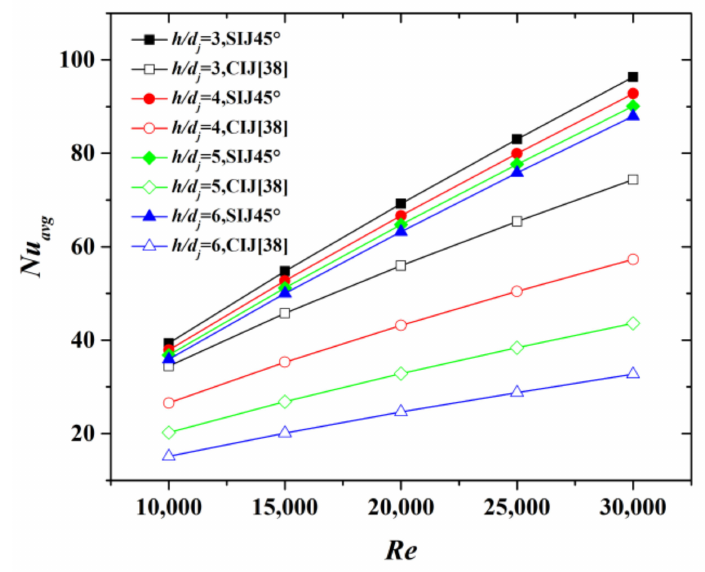
Figure 18. Comparison of average Nu values of SIJ 45 ◦ and that of CIJ in